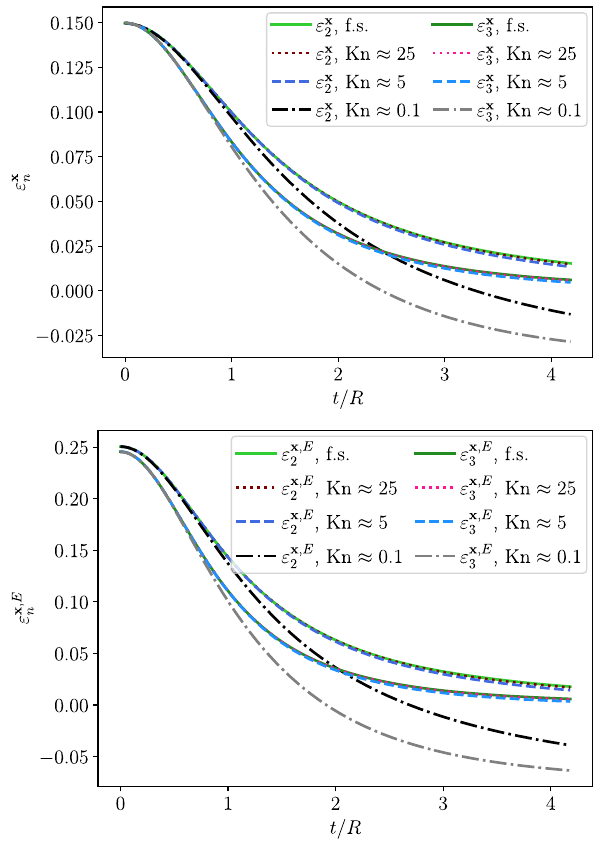
Fig. 8 Timeevolutionofthespatialeccentricitiesinacollisionless(full lines) and in an interacting system with few rescatterings (dotted and dashed lines). The top panel shows particle-number weighted eccen- tricities ε x , ε x , the bottom panel eccentricities ε x , E 2 3 weighting. For comparison, we also show the behavior in a system in the fluid-dynamical regime (dotted-dashed lines)